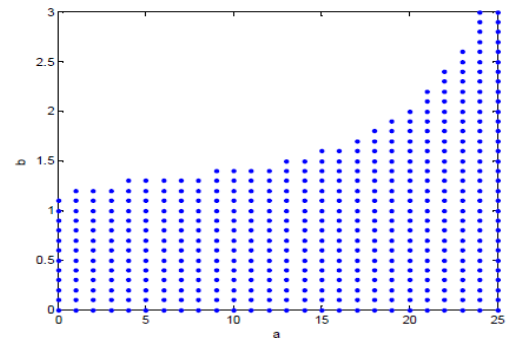
Figure 3. Stability regions using Theorem 10 in Reference [10].